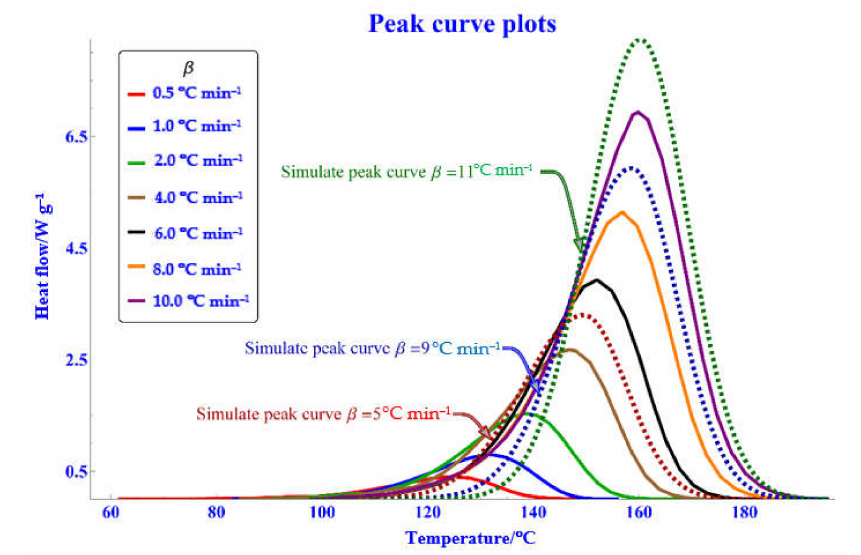
Figure 16. Forecast on different β of Gaussian curve simulation